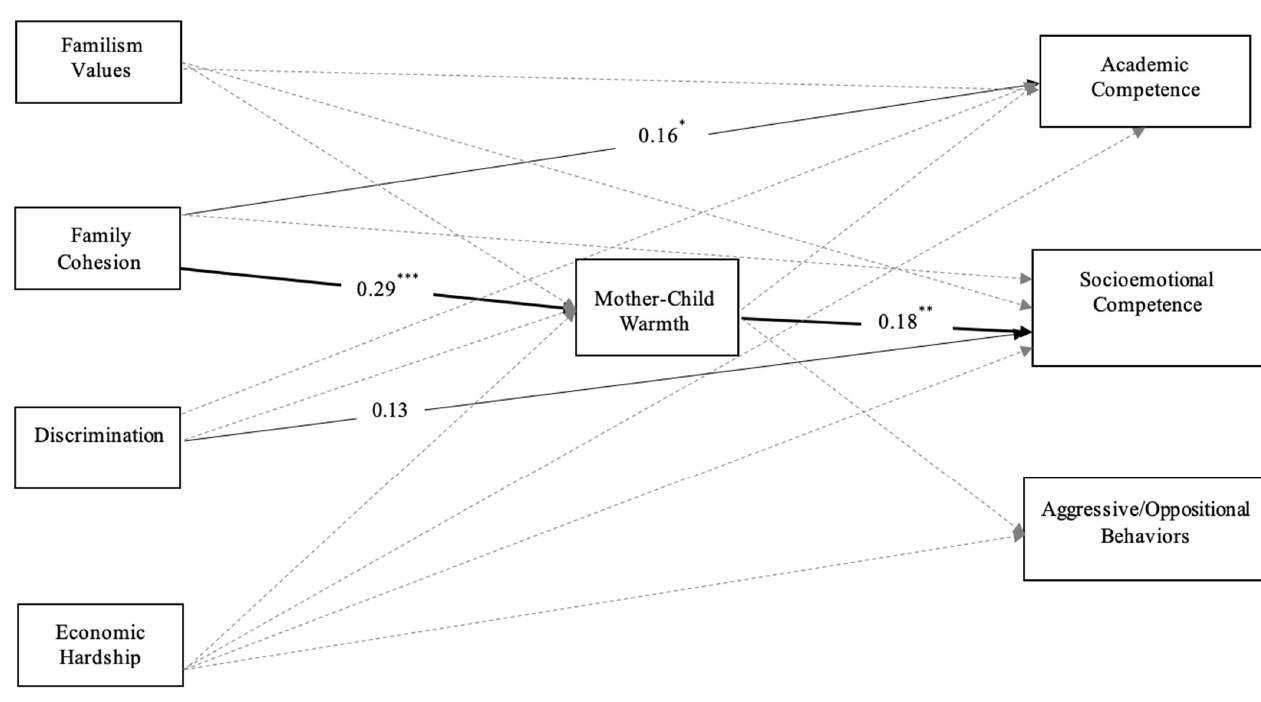
Figure 1. Mothers’ Cultural Assets and Challenges and Children’s Educational Adjustment via Mother–Child Warmth. Note. Standardized parameters are reported. Covariances, residual correlations, and covariates are not shown in the figure for parsimony. Solid lines represent significant direct effects. Bolded lines represent significant indirect paths. Dashed lines represent nonsignificant paths. * p < 0.05, ** p < 0.01, *** p < 0.001. For the second model including mother–child conflict , there were no differences be- tween the fully unconstrained and constrained models by child gender, Δχ 2 (19) = 23.72, p = 0.207, but significant differences were found for sibling birth order, Δχ 2 (19) = 38.87, p = 0.005. Testing specific paths revealed the following birth order differences: family cohe- sion to child socioemotional competence, mothers’ discrimination to aggressive/opposi- tional behavior, and mother–child conflict to socioemotional competence and aggres- sive/oppositional behavior. Thus, these paths and their corresponding indirect effects were allowed to vary for older versus younger siblings, while all other structural paths were constrained to be equal (see Figure 2). Family cohesion was positively associated with children’s socioemotional competence for older siblings ( b = 0.17, p = 0.027), but no significant association emerged for younger siblings ( b = − 0.08, p = 0.166). Mothers’ reports of discrimination were associated with children’s socioemotional competence for both older and younger siblings ( b = 0.12, p < 0.001). Mothers’ discrimination also was nega- tively associated with aggressive/oppositional behaviors for younger siblings ( b = − 0.21, p